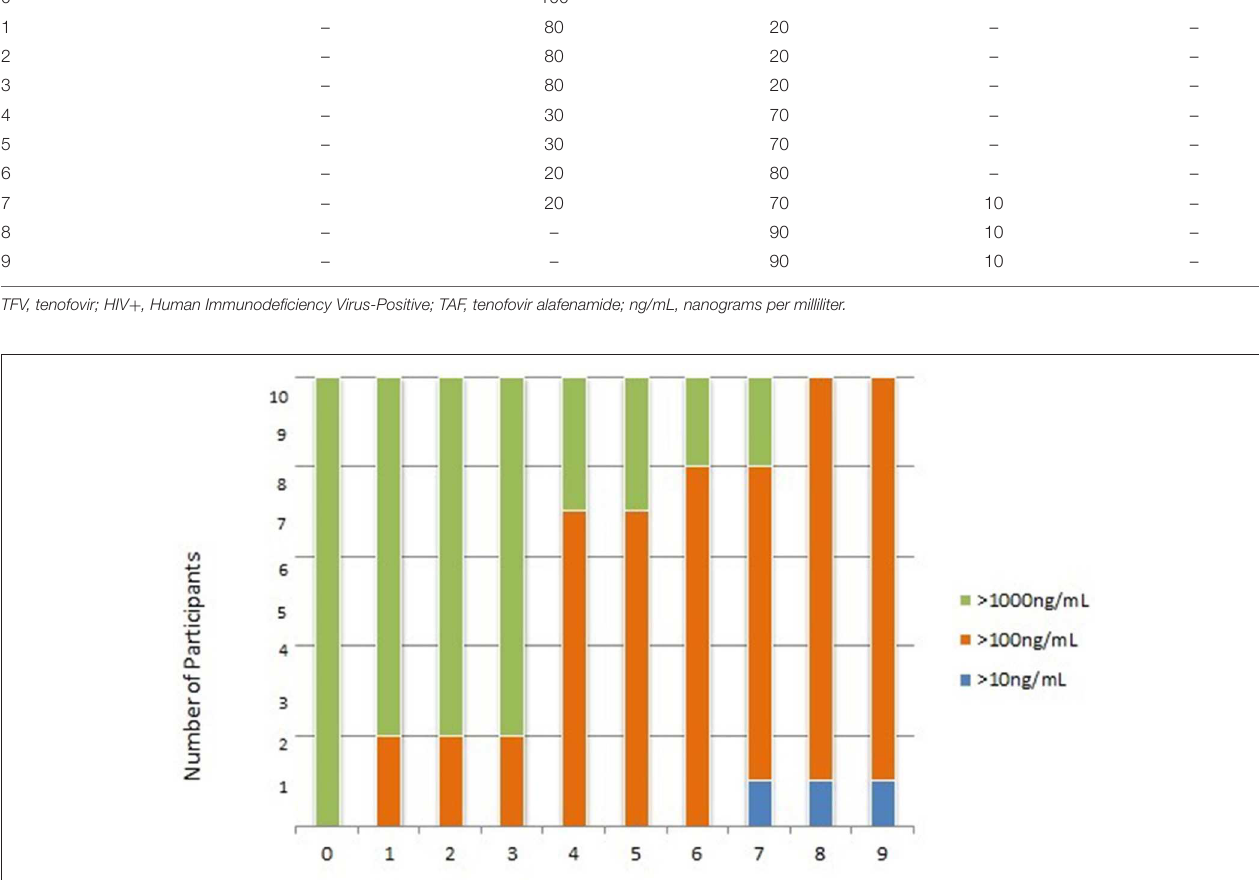
yielded TFV concentrations similar to those observed in the single-dose